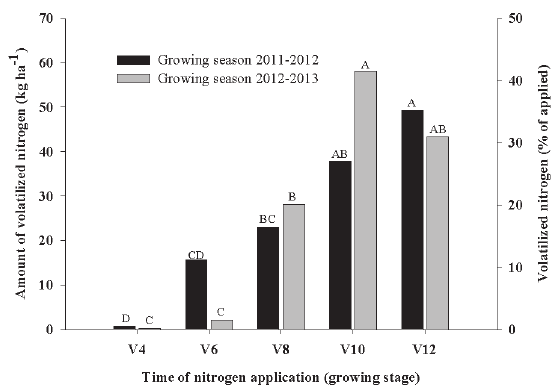
Figure 2 - Amount and percentage of volatilized nitrogen from urea sidedressed during different corn growing stages. For each growing season, columns with different letters differ between each other by Tukey’s test ( p ≤0.05). Coefficients of variation for the 2011–2012 and 2012–2013 growing seasons were 28 and 39%,